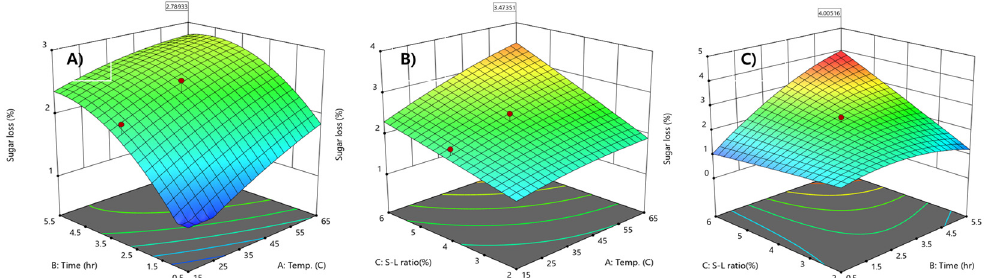
Figure 3. Response surface curves representing the effects of three variables, including time, temperature, and S-L ratio on sugar loss from APH of S. obliquus . Time versus temperature ( A ); temperature versus S-L ratio ( B ), time versus S-L ratio ( C ).